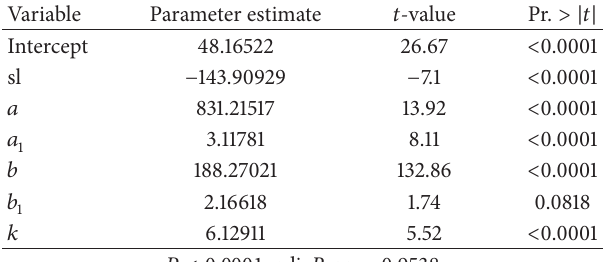
Table 10: Statistics of multiple linear regression for NPV for selected sampling